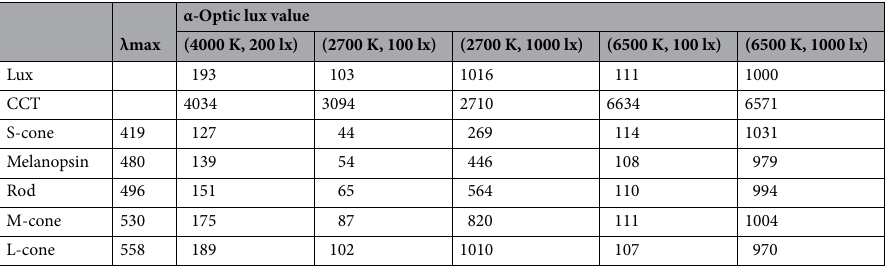
Table 1. Spectrally weighted α-Optic lux level at eye levels for each lighting condition based on Lucas et al. 91 .